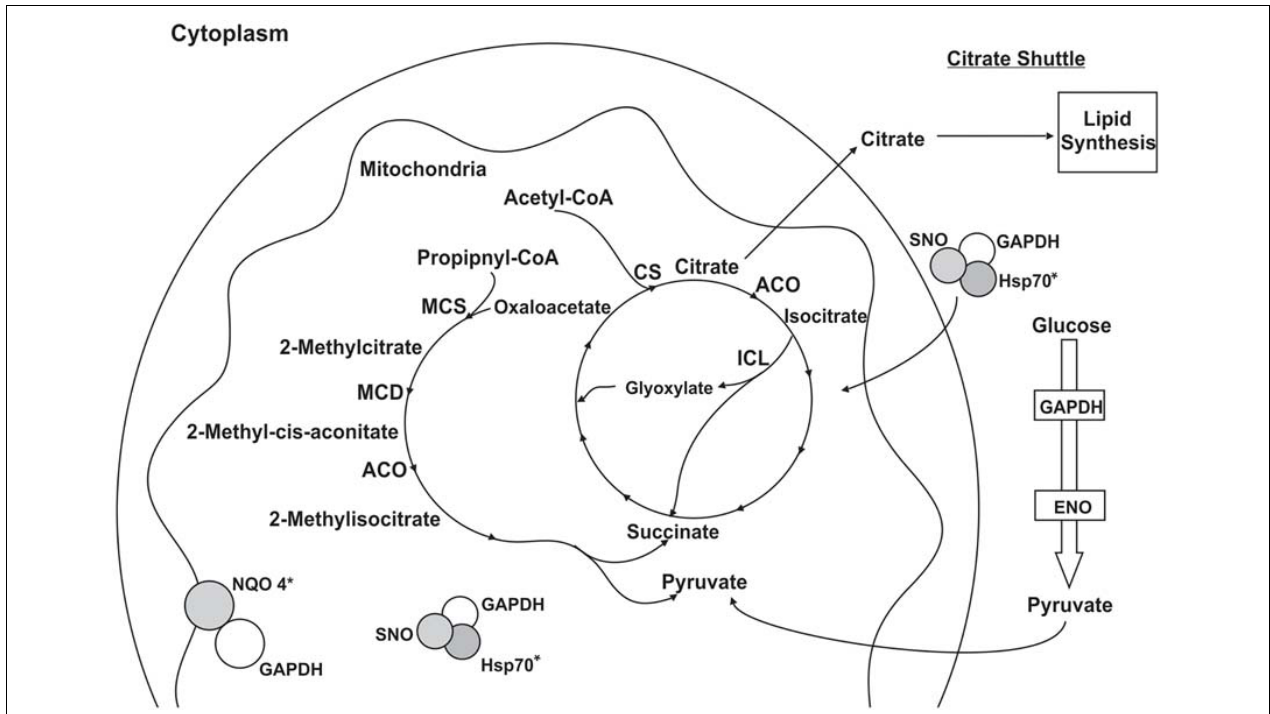
FIGURE 2 | Schematic model of the metabolic processes involving GAPDH through PPIs in P. lutzii mycelium phase. All proteins shown in the figures interacted with GAPDH as a result of the chromatographic and BN-PAGE approaches. GAPDH (glyceraldehyde 3-phosphate dehydrogenase), SNO (nitrosylation), CS (citrate synthase), ACO (aconitase), ICL (isocitrate lyase), MCS (2-methylcitrate synthase), MCD (2-methylcitrate dehydratase), HSP60 (heat shock protein 60), HSP70 (heat shock protein 70), NQO4 (NAD(P)H:quinone oxidoreductase type IV) and ENO (enolase). Asterisks indicate proteins identified as GAPDH partners by both the chromatographic and BN-PAGE